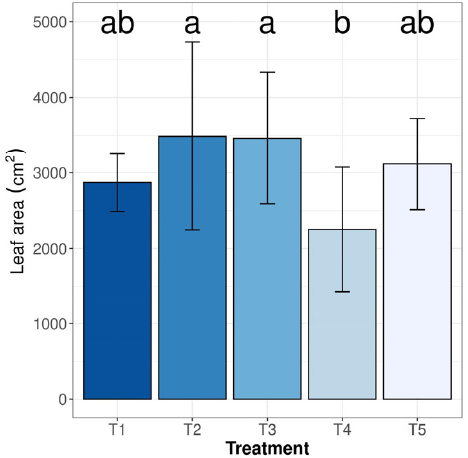
Figure 2. Leaf area of raspberry Himbo Top on day of year 196 depending on substrate. T1 = Commercial Peat (P) 90% + Compost A (CA) 10%; T2 = P 80% + CA 20%; T3 = P 60% + CA 40%; T4 = Commercial Peat (P) 100%; T5 = P Commercial Peat 100% + Osmocote. Different letters indicate statistically significant differences after ANOVA and Duncan post-hoc test at p -value < 0.05.